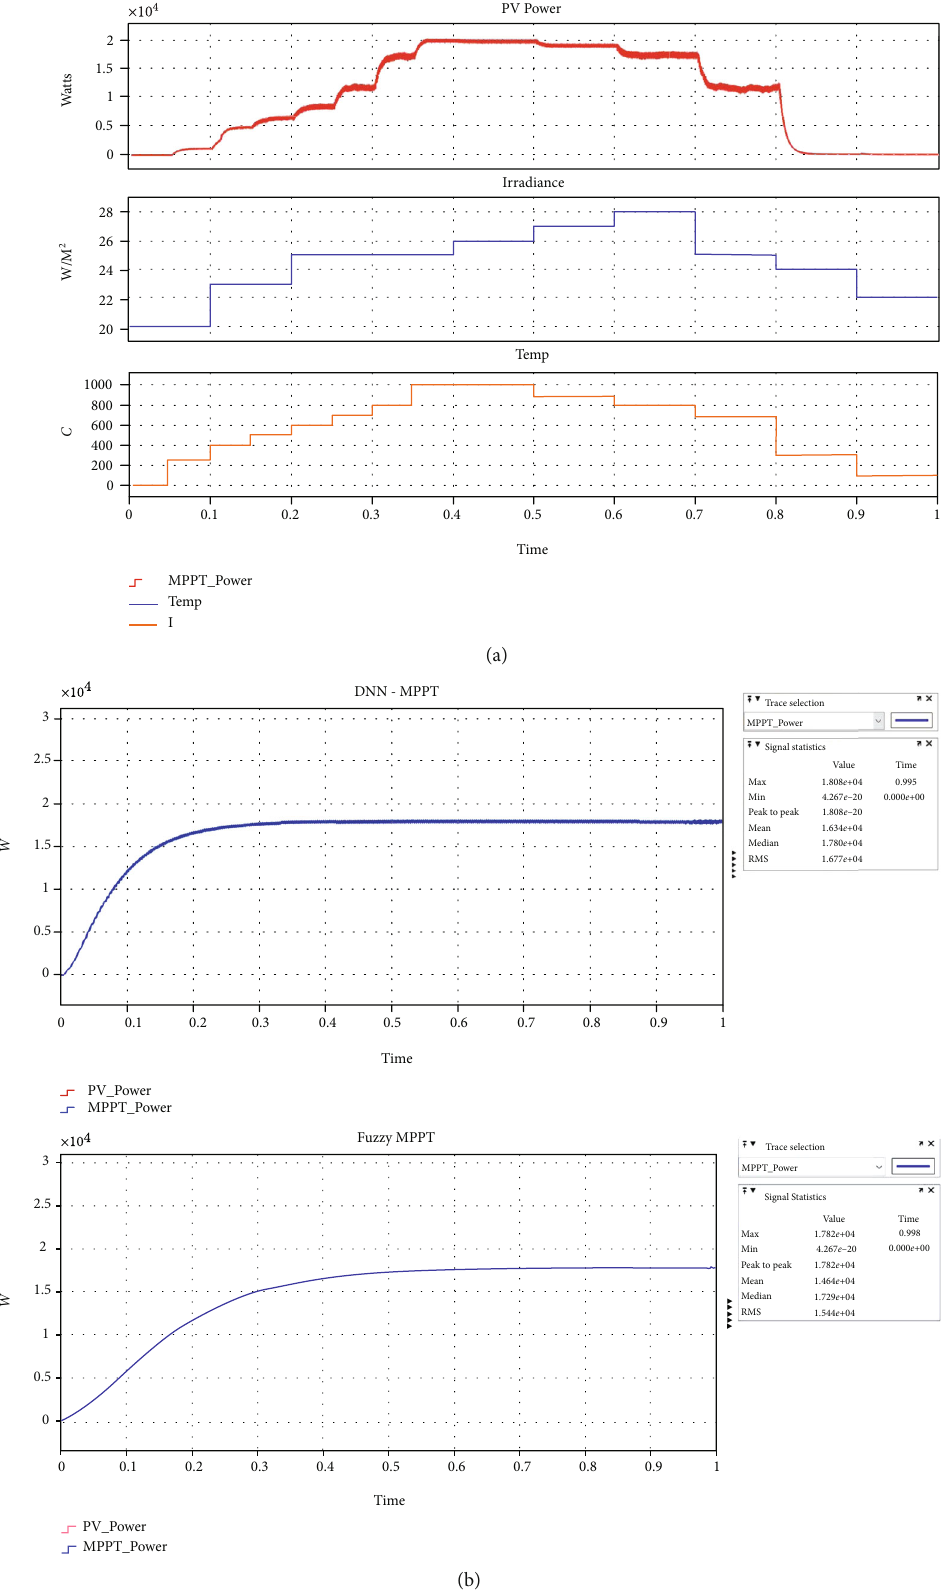
Figure 9: (a) Simulation results of DNN-PV MPPT power with respect to irradiance and temperature. (b) Comparison of fuzzy- and DNN- based MPPT